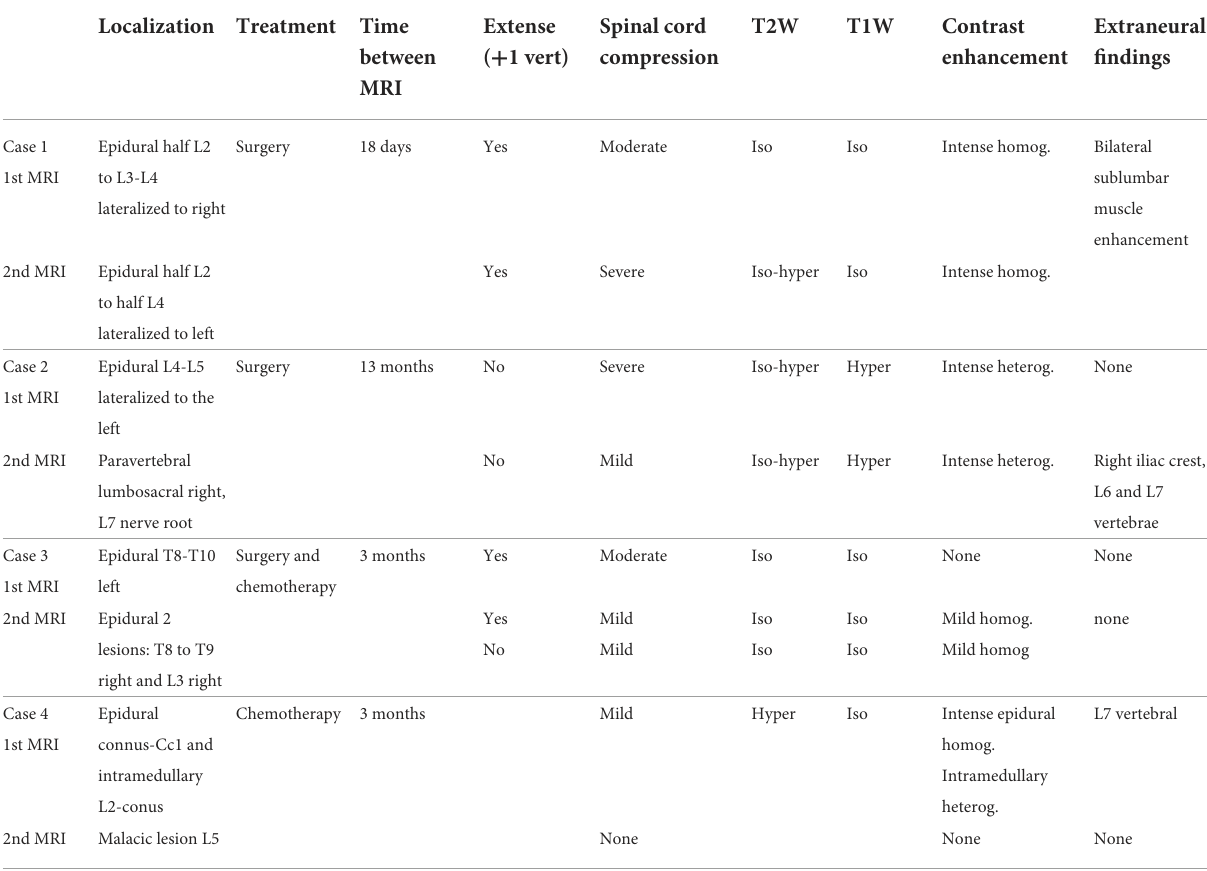
TABLE 3 MRI distribution and imaging pattern of spinal lymphoma on follow-up MRI performed in 4 cats. Localization Treatment